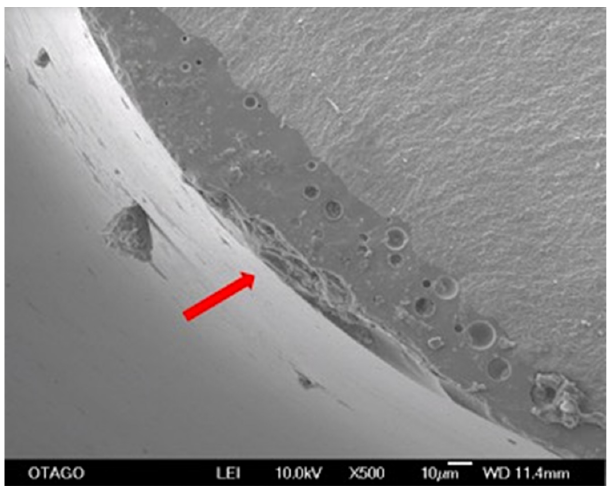
Figure 7. SEM image showing the presence of voids in the glaze layer and a red arrow showing the direction of crack propagation at 500x magnification (group DG).